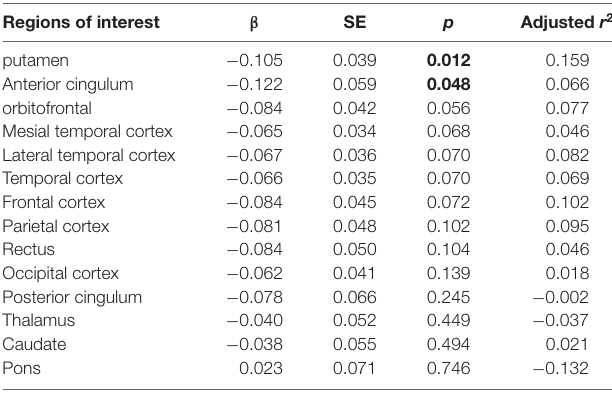
TABLE 4 | Association between rs162009 and 18 F Florbetapir SUVRs.